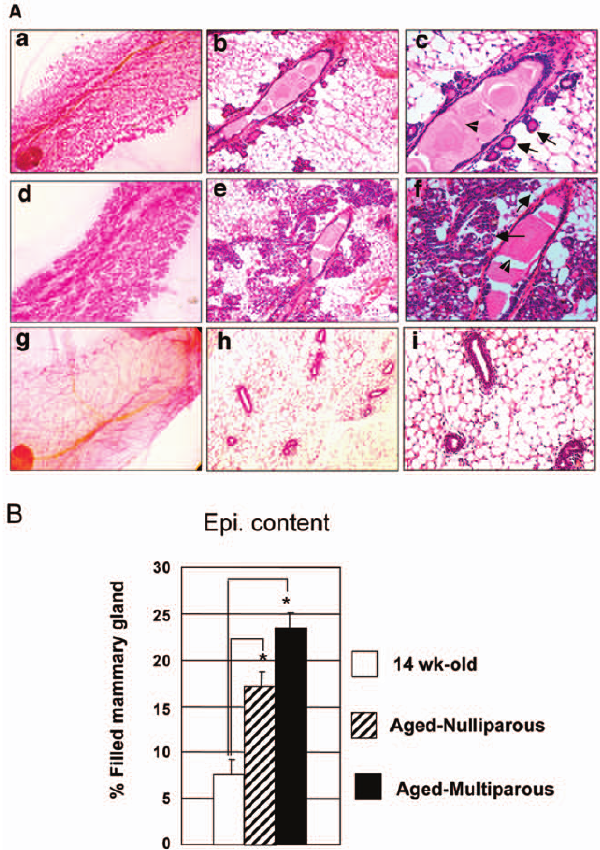
Figure 1. Analysis of morphology, histology and epithelial content of control, aged -nulliparous and aged-multiparous FVB/N-RC mammary glands. ( A ) Photomicrographs of aged- nulliparous (panel a, b and c), aged-multiparous (panel d, e and f) and 14-wk-old (panels g, h and i) control mice whole-mounts and histological secions. Whole-mounts of the aged-nulliparous (panel a compare to panel g) and aged-multiparous (panels d compare to panel g) mice had the appearance of mammary glands from pregnant mice. Similary sections of mammary glands of the aged-nulliparous (panel b and c) and aged-multiparous (panel e and f) mice had the appearance of those from pregnant mice. Mammary glands of the aged-nulliparous (Panel b and c) mice displayed few budding alveoli (arrows, panel c) emanating from primary ducts; the aged-multiparous glands consisted of higher order of branching containing extensive numbers of fully developed alveoli (arrows, panel e and f). Also, the ducts of the aged- nulliparous and multiparous mice are dilated and filled with secretory material (arrow head in panel c and f). The control 14-wk-old nulliparous female mammary glands were composed of primary ducts (Panel g, h and i). Magnification, Panels a, d and g are at 5 6 , panels b, e and h are at 10 6 and panels c, f and i are at 20 6 . ( B ) Quantification of epithelial content of mammary glands from 14-wk-old control, aged- nulliparous and aged-multiparous mice, was conducted on the whole- mounts using AxioVision 4 Module AutoMeasure Program. Aged- multiparous mice had the highest epithelial contents followed by the aged-nulliparous and the control mice. Data represent mean 6 SEM from ten mice per group. In Figure 1B * indicates a statistically significant difference of p , 0.05.